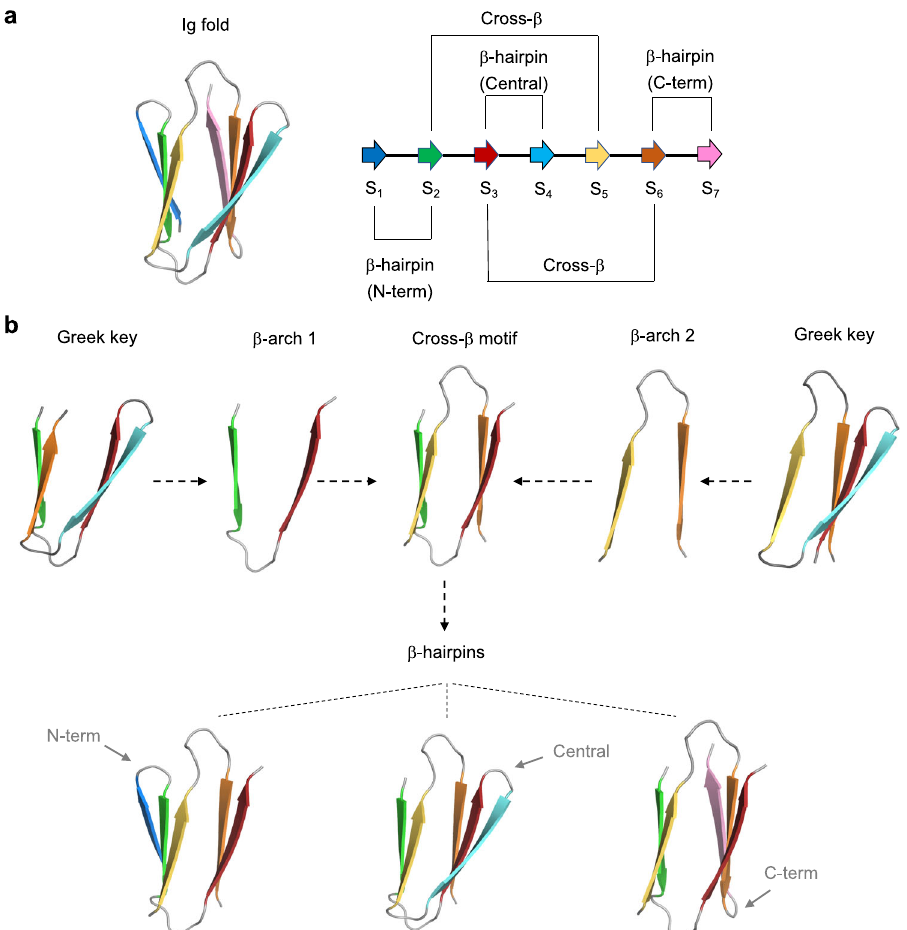
Fig.1|Topologyofimmunoglobulin-likedomains.a Three-dimensionalcartoon representation of an Ig structure formed by seven β -strands (left); and backbone hydrogenbondpatterns (annotated thinlines) betweenpaired β -strands along the sequence(right).Cross- β interactionshavehighersequenceseparation(andhigher contactorder)than β -hairpins,whichslowsdownfolding. b β -archesofthecross- β